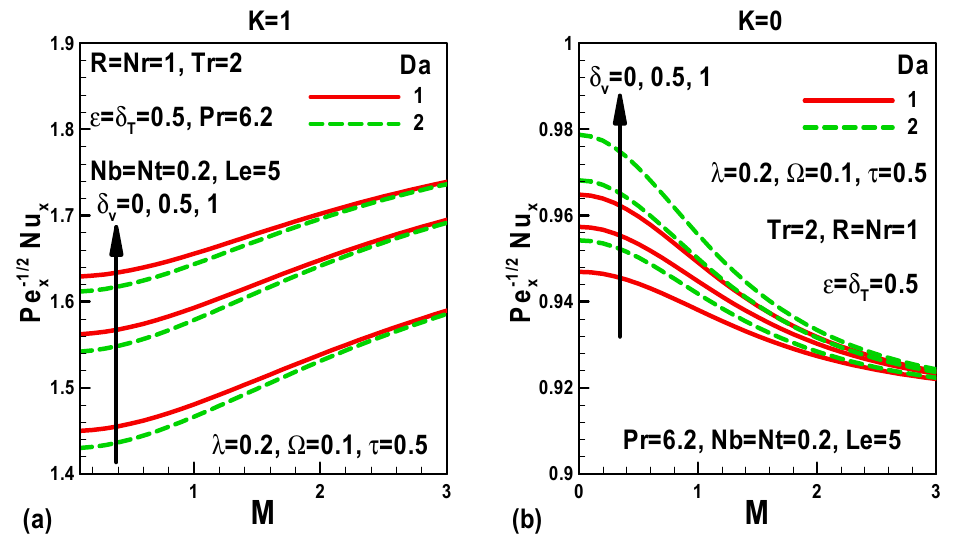
Figure 13. Effects of Darcy number, velocity slip, and magnetic parameters on Nusselt numbers ( a ) with pressure gradient and ( b ) without pressure gradient.